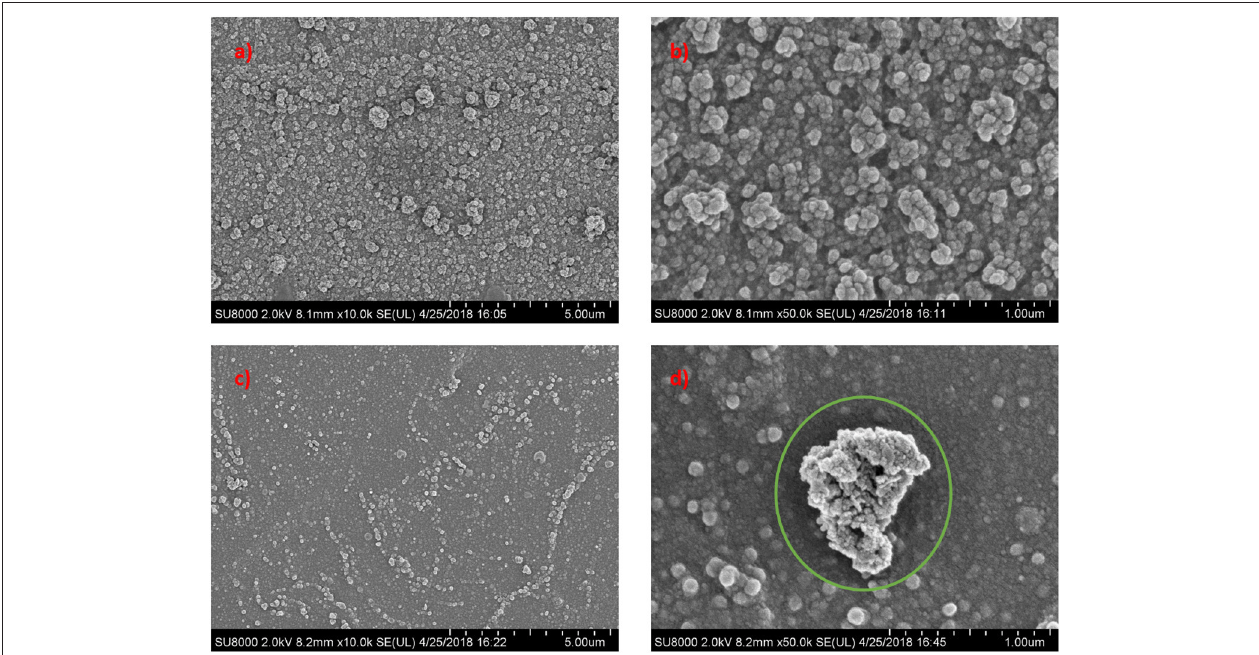
FIGURE 4 | Surface morphological structures of pristine TFC and LDH-filled TFN membrane at different magnifications (a) TFC (c) TFN 2 at 10k magnification; (b) TFC (d) TFN 2 at 50k